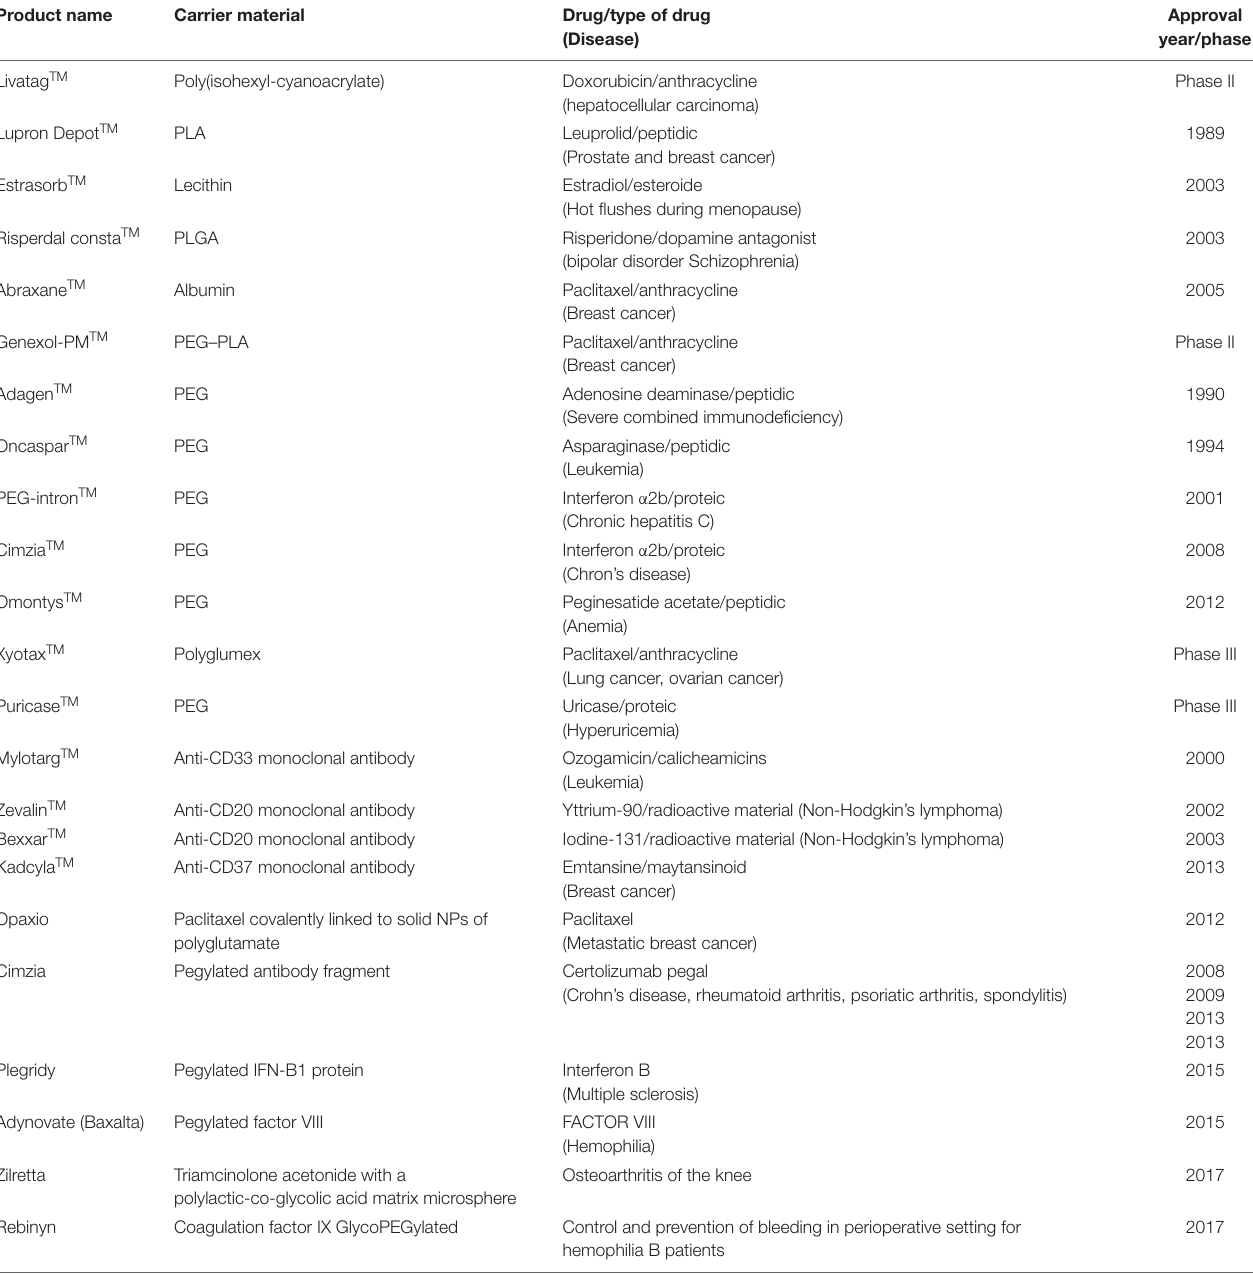
TABLE 1 | List of nanoengineered polymers for drug delivery applications (Felice et al., 2014; Bobo et al., 2016; Patra et al.,